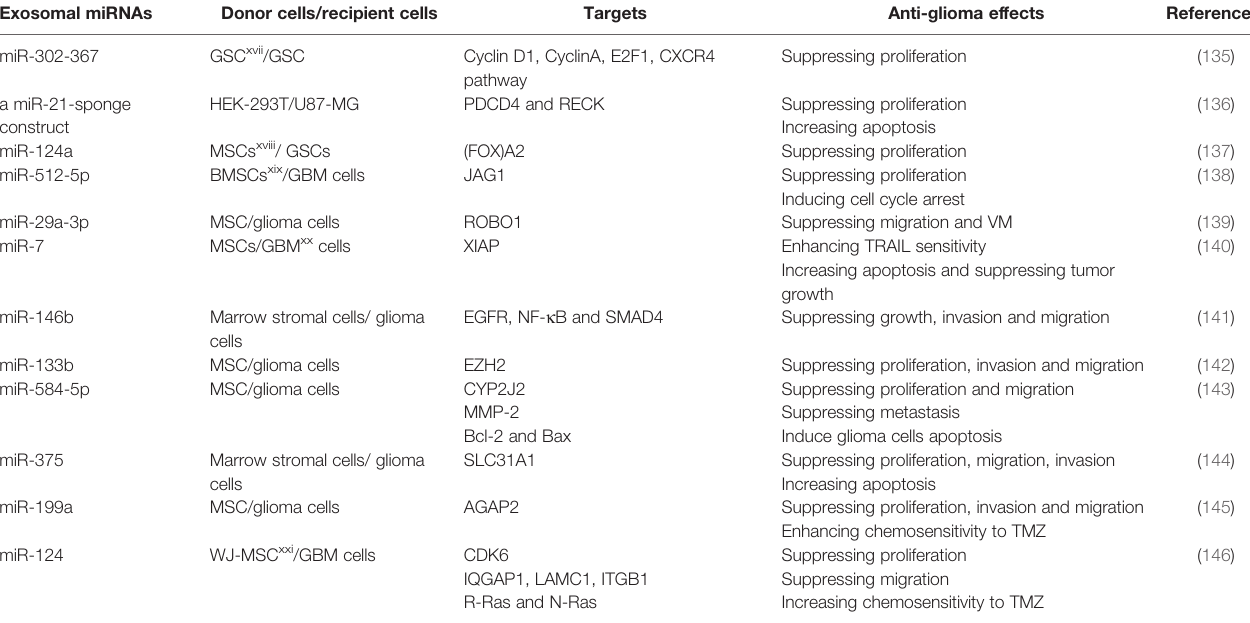
TABLE 3 | Identi fi cation of exosomal miRNAs as potential anti-glioma therapeutics. Exosomal miRNAs Donor cells/recipient